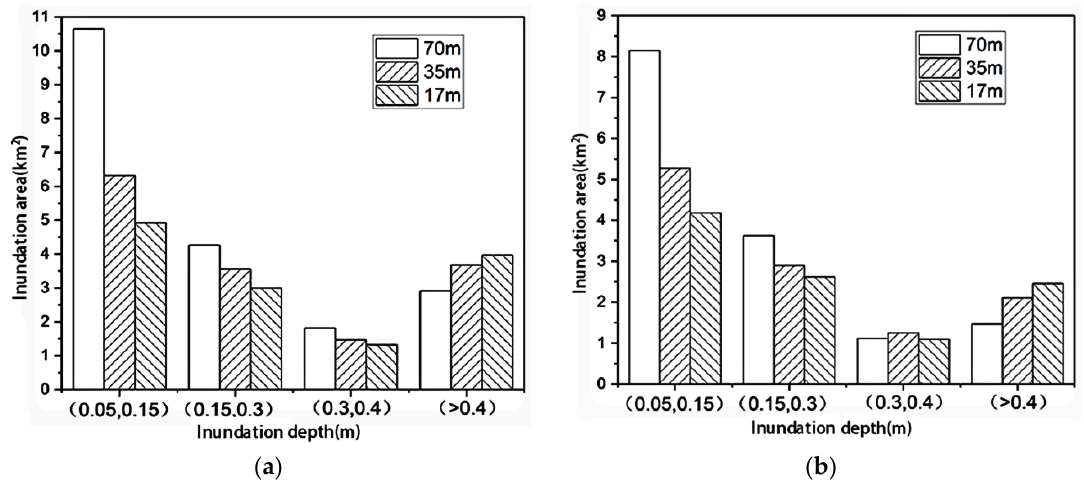
Figure 10. The inundation area for different inundation depths at 17, 35, and 70 m resolutions: ( a ) 10-year return period; ( b ) 2-year return period.